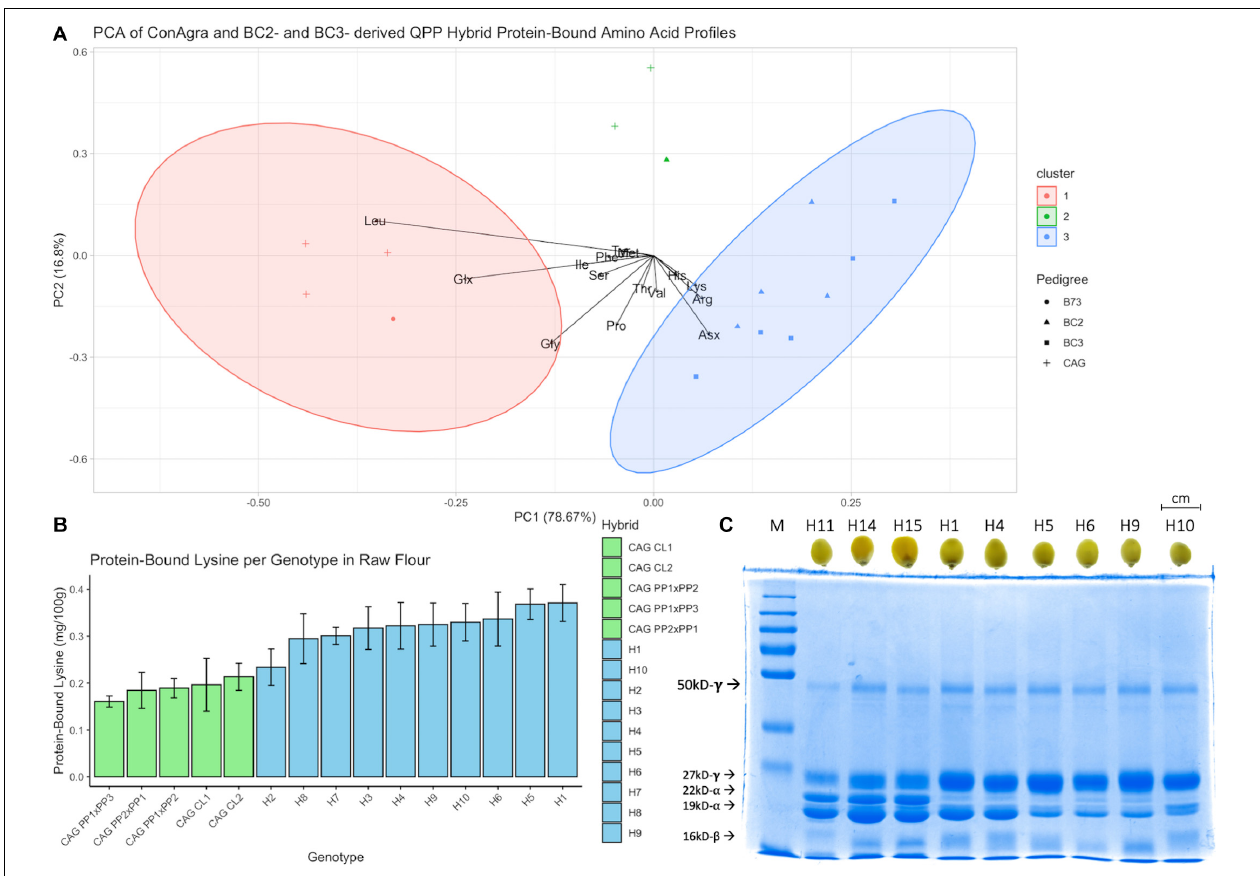
FIGURE 2 | Protein profiling of QPP and ConAgra elite lines. (A) Principle component analysis (PCA) of protein-bound amino acids in raw flour of ConAgra elite lines, B73 for reference, and QPP hybrids revealed a distinct segregation between QPP and original popcorn-derived cultivars. B73 grouped with ConAgra lines H12, H13, and H14, while H11 and H15 independently segregated with QPP H2. QPP H2 had a distinct proteome compared to all other QPP hybrids and similar lysine levels compared to ConAgra lines. (B) Protein-bound lysine in raw flour of all genotypes revealed significantly higher lysine levels in all QPP lines except H2. (C) Zein extraction and SDS-PAGE analysis of randomly selected kernels revealed a significant reduction in 22-kD-alpha zein, varying production of 19-kD-alpha zein, and increased expression of the 27-kD γ -zein in QPP lines compared to ConAgra lines, consistent with a homozygous opaque-2 profile. Compositely, these results verified the successful introgression and stabilization of the homozygous mutation in the BC 2 F 5 and BC 3 F 4 QPP populations.